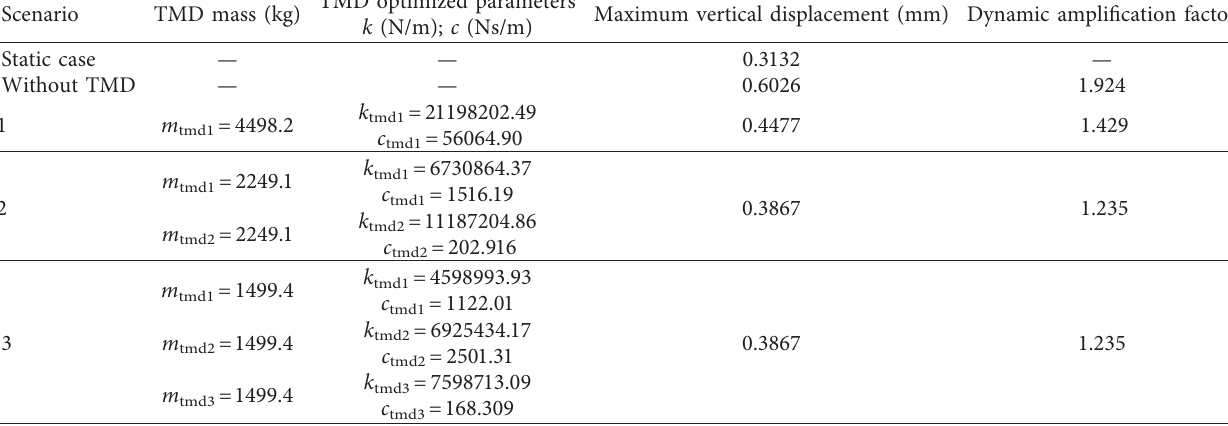
Table 4: Results of the proposed optimization procedure for 50km/h.